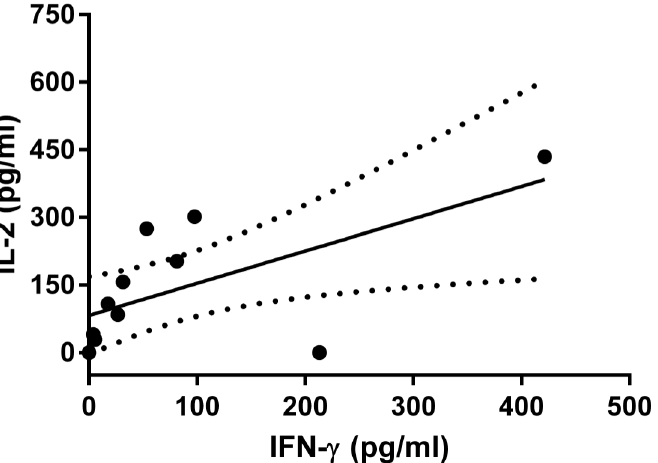
Fig 5. Linear regression of IFN- γ and IL-2 responses in plasma from SLA-stimulated whole blood plasma in NVL lp+ subjects. A significant correlation was detected between these variables (r = 0.616, P = 0.018).